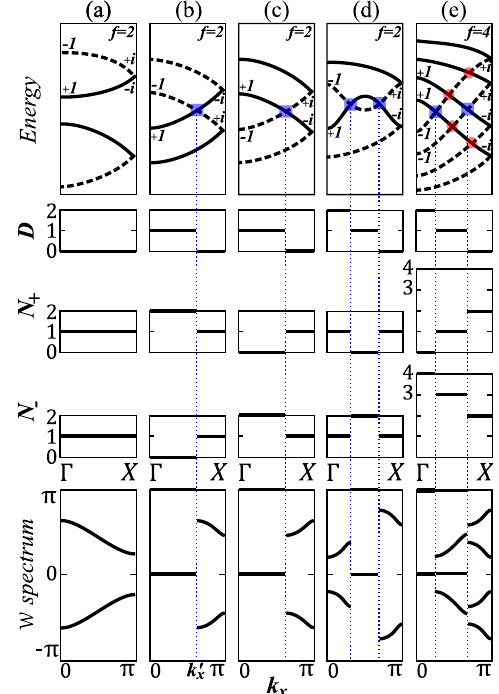
FIG. 4. Characterization of a generic insulator (a) and various topological metals (b) – (e). Top row: Band structures along the screw line Γ X . Solid (dashed) lines correspond to bands in the odd (even) screw representation, i.e., having screw eigenvalue þ exp ð − ik x = 2 Þ [ − exp ð − ik x = 2 Þ ]. For each of (a) – (e), the filling ( f ) is indicated in the top right-hand corner, and we assume that there are no Dirac crossings along the other screw line YM . Blue circles denote crossings between a filled and an unfilled band, whereas red circles mark crossing between bands that are both filled (unfilled). Second, third, and fourth rows: Respectively, the numbers of Dirac crossings ( D k ), of even, filled states ( N ), and þ ; k of odd, filled states ( N − ), for k along Γ X . Bottom row: ; k Eigenvalue phases of the W ð k x Þ